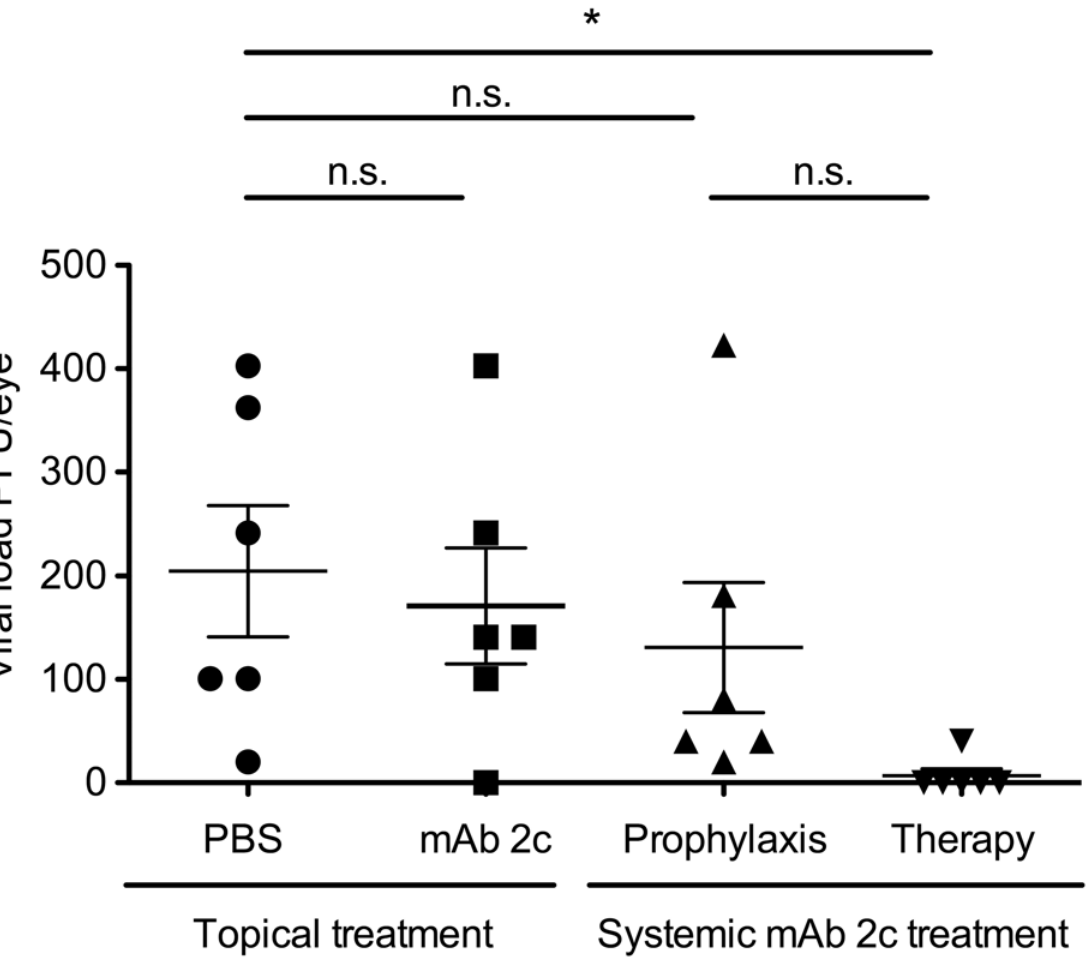
Figure 9. Effective virus neutralization in HSV-1 KOS infected eyes by mAb 2c. Representatively, six mice from each group were killed at day 5 post infection. Primary infected eyes were homogenized and inspected for viral loads using a standard plaque assay. Statistical analysis was undertaken with a nonparametric ANOVA test. Comparisons were considered significant at * P < 0.05. Error bars represent the SEM.